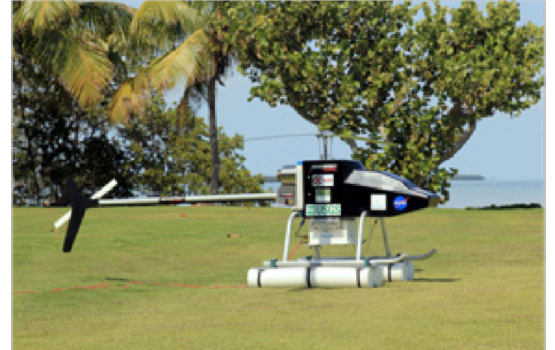
Figure 4. Vision-II UAS carrying NovaSol hyperspectral imager